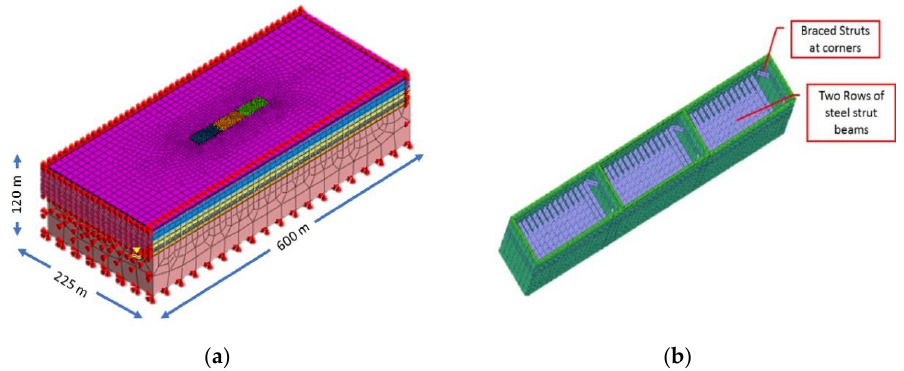
Figure 8. Three-dimensional finite element model. ( a ) Geometry dimensions and boundary conditions. ( b ) Temporary two steel strut rows.